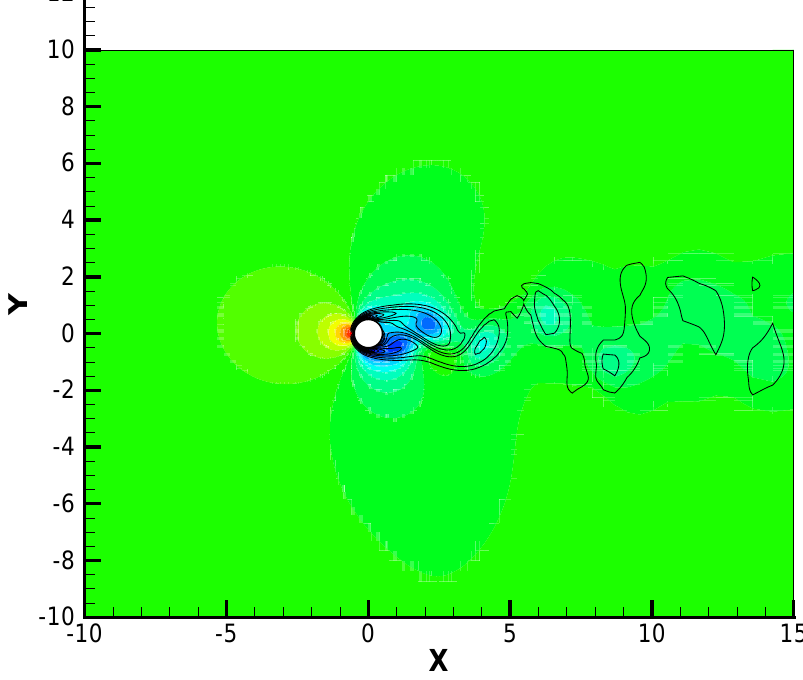
Figure 7. Pressure and vorticity contours for the case of the flow past a cylinder at Re =